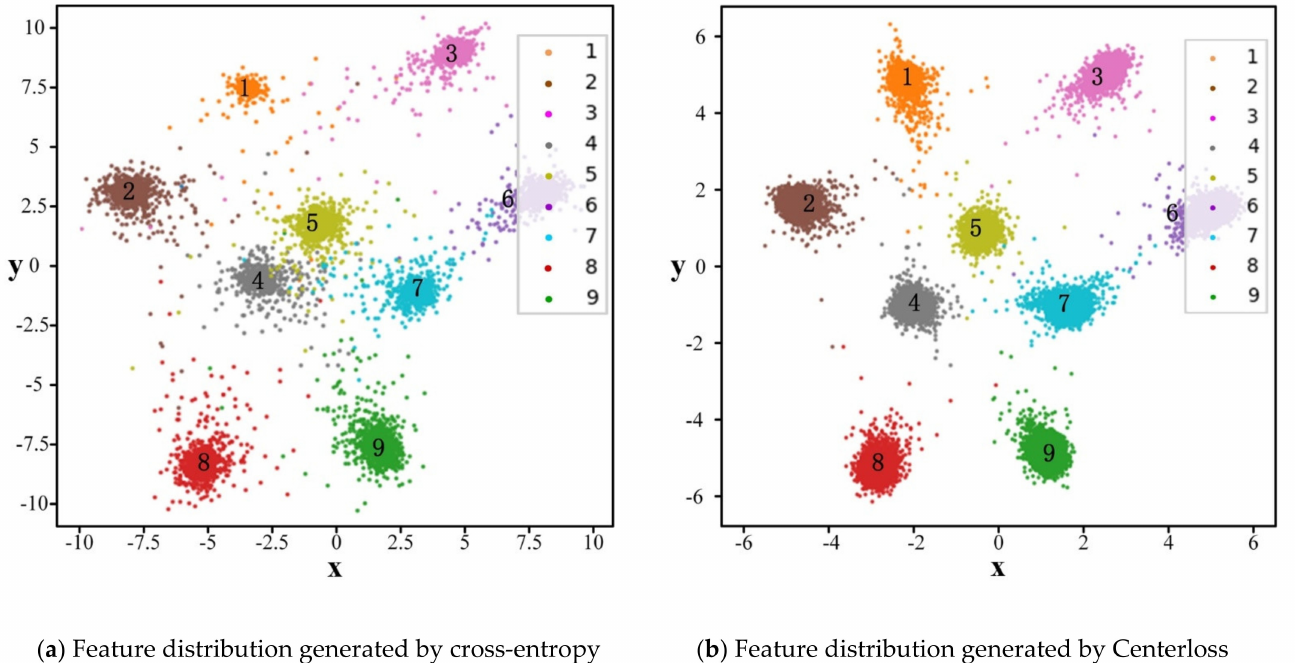
Figure 9. Visualization of characteristic distribution of various diseases. The abscissa and ordi- nate represent the distance between sample points, where 1:9 in the confusion matrix represents Apple—healthy, rust, scab; Cassava—bacterial blight, brown streak, healthy, mosaic virus; Cotton boll—blight,